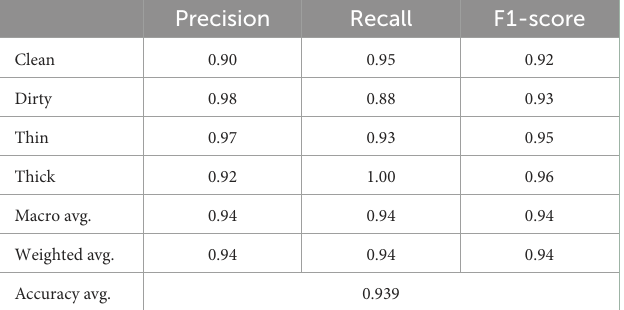
TABLE 7 Precision, recall, F1-score of combined features using KNN.